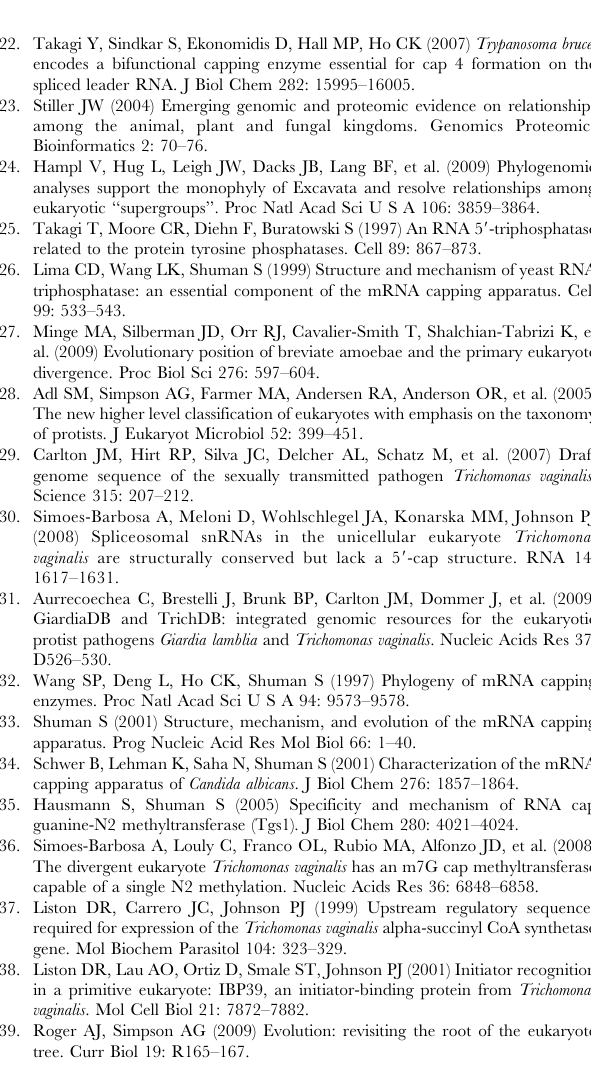
Figure S4 Alternative protein phylogenetic analyses of TvCE. A. Global phylogeny of GTases with the same alignment used to generate phylogeny depicted in Figure 8 with the iridovirus sequence removed. The arrow indicates the branch leading to all TPasePL-GTase configured sequences. B. Global phylogeny of GTases with the same alignmnent used to generate phylogeny depicted in Figure 8 with the Giardia sequence removed. The arrow indicates the branch leading to all TPasePL-GTase configures sequences. C. Same as in A with the Giardia sequence further removed. D. Phylogeny of TPasePL-GTase configured sequences with the same alignment used to generate the phylogeny depicted in Figure 9 with the iridovirus removed. In all trees the species names are abbreviated with the first three letters of the genus and species name (full names are listed in supplementary Table S1) and the LG model with G was used. Shown values are bootstrap proportions (%, 100 replicates), values . 50% are